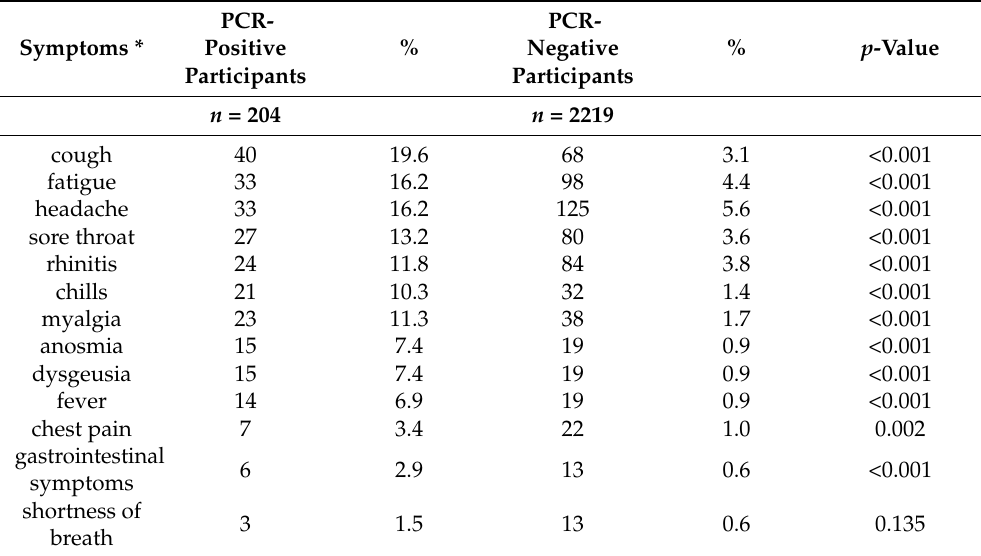
Table 3. Clinical characteristics of 2423 PCR-tested participants without COVID-19 contacts.